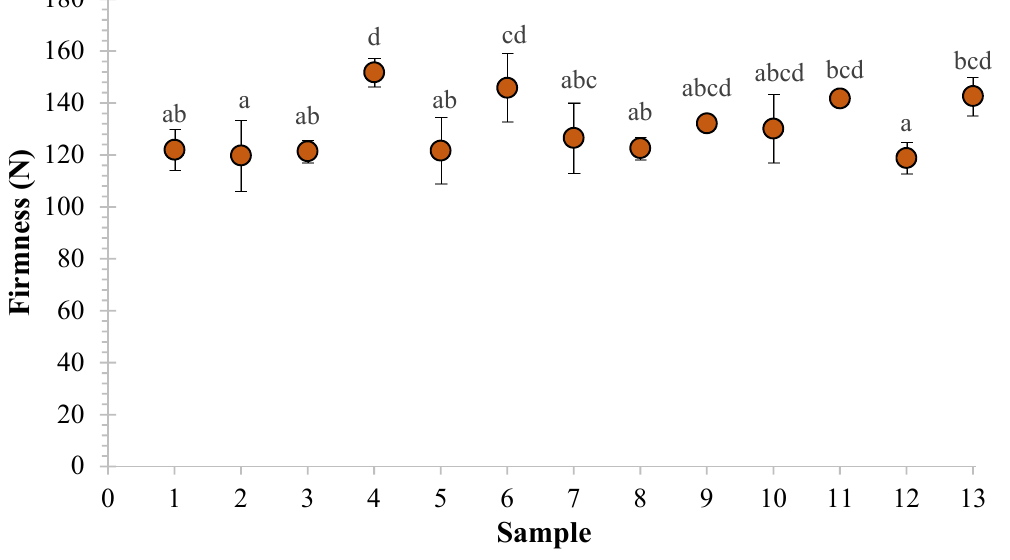
Figure 2. Visual of the distribution of average firmness values of bean samples. Error bars indicating standard deviation of firmness for each sample are included.